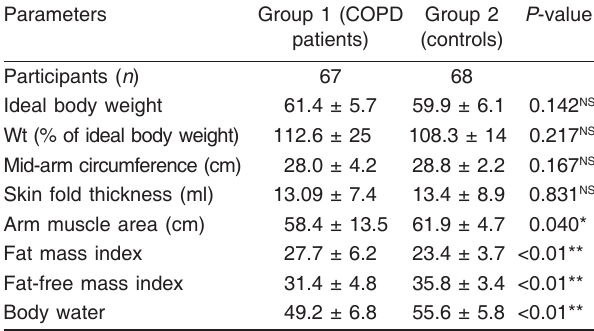
Table 2 Anthropometric parameters among the studied groups